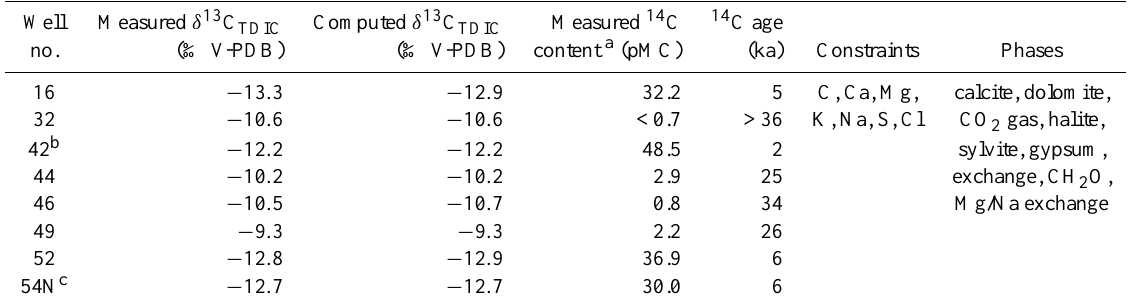
Table 3. Radiocarbon piston-flow ages of groundwater in the confined zone of the investigated part of the Neogene aquifer, calculated using NETPATH code.